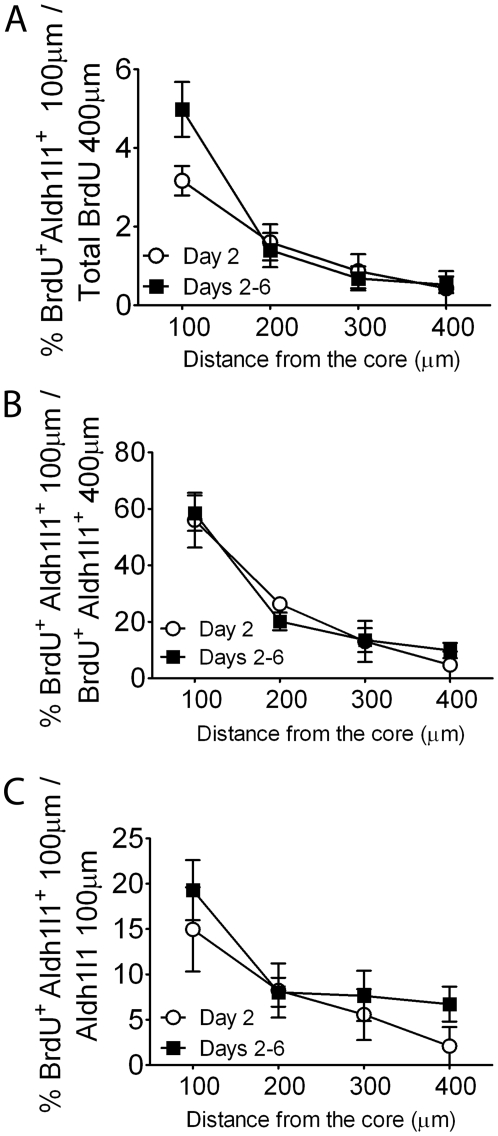
Astrocyte proliferation as a function of distance from the infarct core.BrdU labelling on day 2 or 2–6 cumulatively shows a small percentage of mature Aldh1l1+ astrocytes proliferate after MCAO within 400 µm of the ischemic core. Stereological analysis of astrocyte proliferation as a function of distance shows that Aldh1l1+ cells mainly co-express BrdU in the first 200 µm from the infarct area; the number decreases dramatically with distance. The fraction of proliferating astrocytes compared to all proliferating cells in the penumbra is low (A), and the fraction of proliferating astrocytes present falls rapidly with distance (B), and the fraction of all astrocytes present that proliferate is highest close to the core (C).